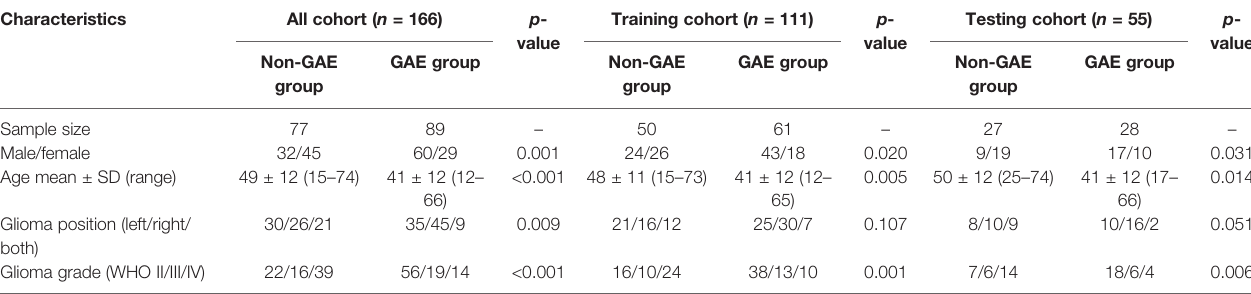
TABLE 1 | Clinical characteristic of patients in the training and testing